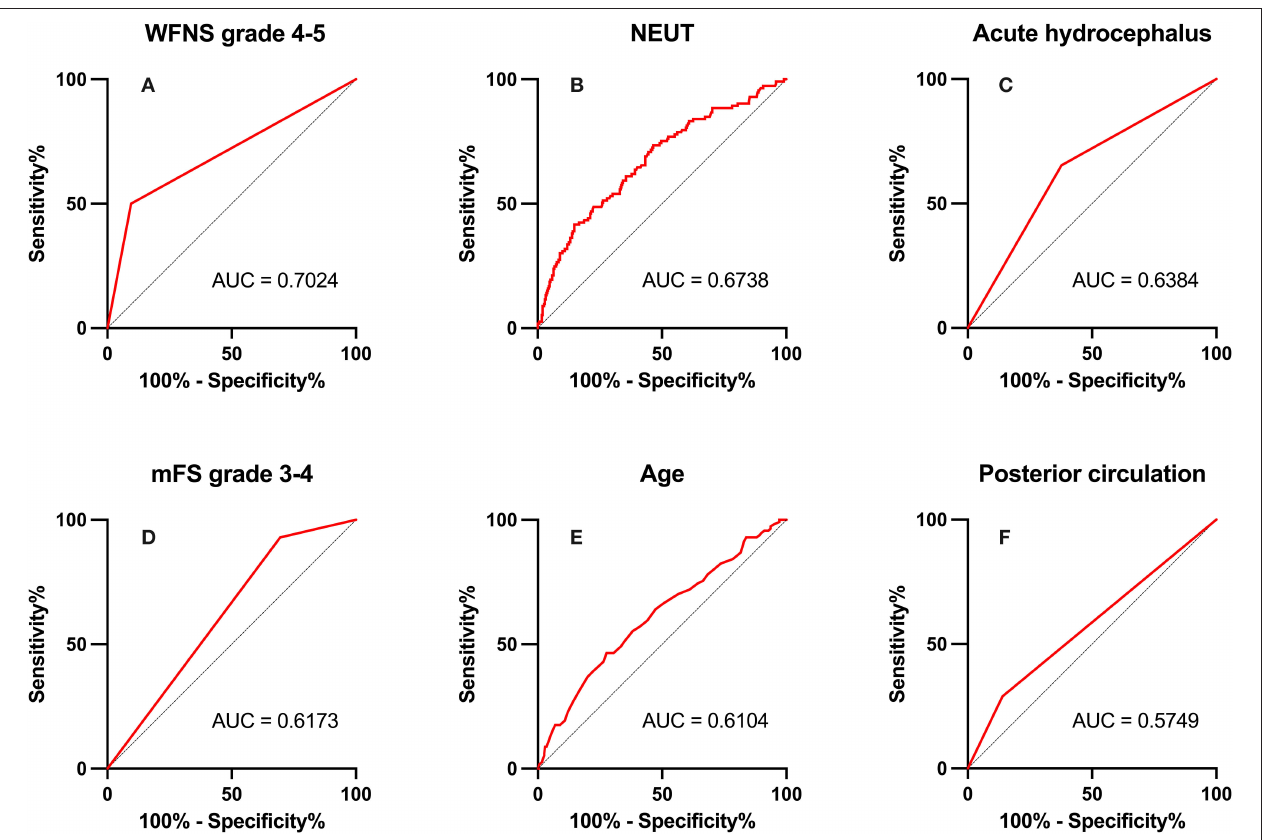
FIGURE 2 | Area under the receiver operating characteristic (AUC) values for preoperative factors that predicted postoperative pneumonia in the endovascular coiling (EC) group. (A) World Federation of Neurosurgical Societies (WFNS) grade 4–5 (AUC = 0.702, 95% CI = 2.67–8.80; p < 0.001). (B) Neutrophil (NEUT; AUC = 0.674, 95% CI = 1.06–1.22; p < 0.001). (C) Acute hydrocephalus (AUC = 0.638, 95% CI = 1.01–3.00; p = 0.048). (D) modified Fisher Scale (mFS) grade 3–4 (AUC = 0.617, 95% CI = 1.15–5.89; p = 0.022). (E) Age (AUC = 0.610, 95% CI = 1.02–1.07; p = 0.001). (F) Posterior circulation (AUC = 0.575, 95% CI = 1.12–3.83; p =